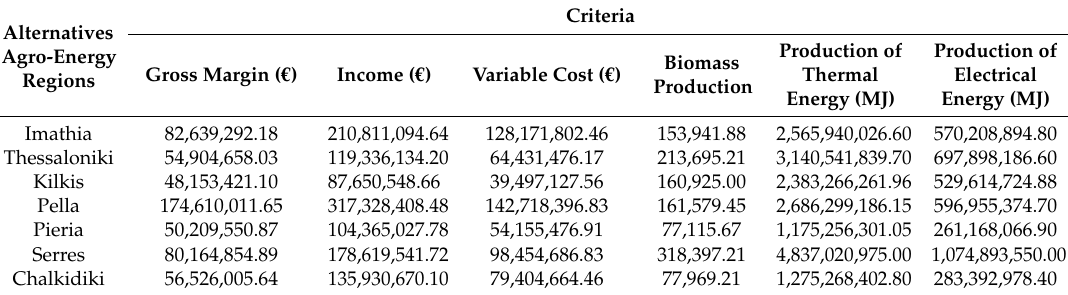
Table 3. Calculation of the six criteria for ELECTRE III model.